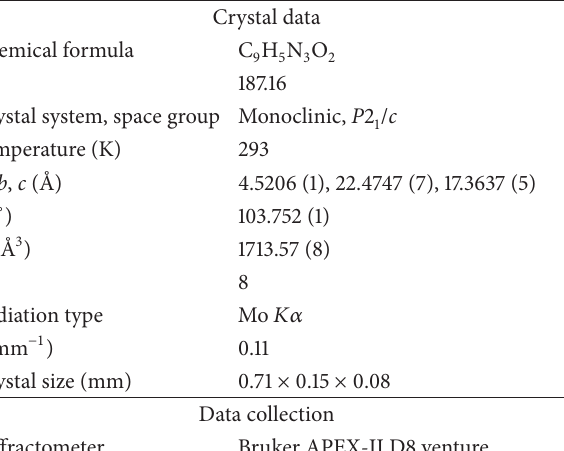
Table 1: Experimental details of X-ray analysis for compound 2